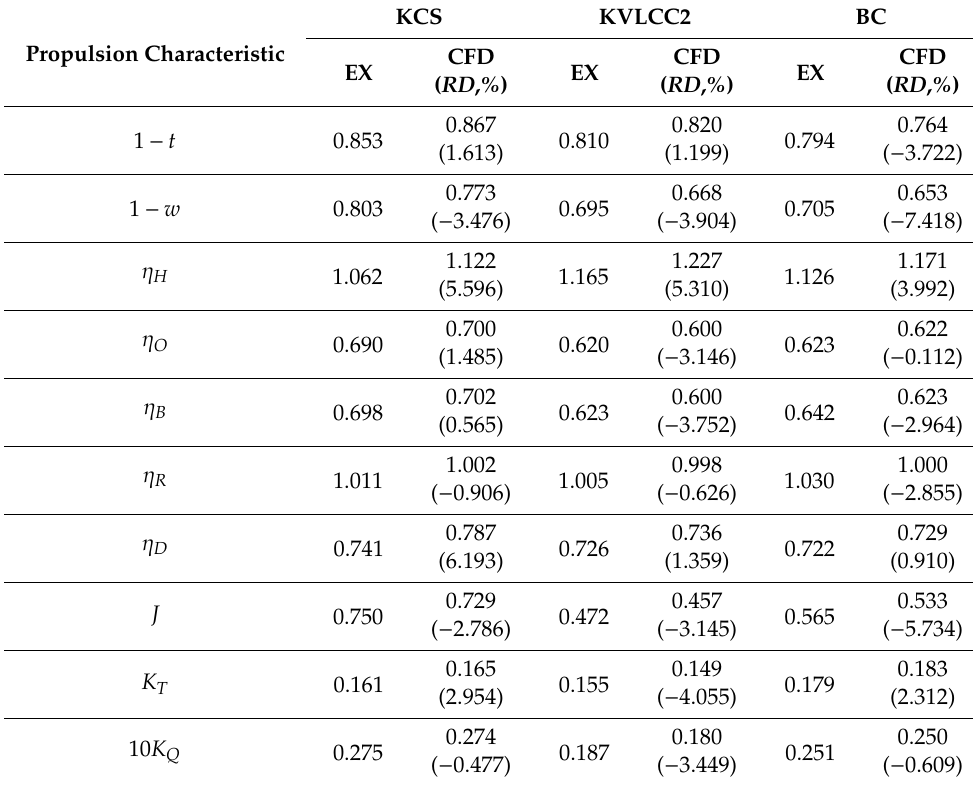
Table 12. The validation study for propulsion